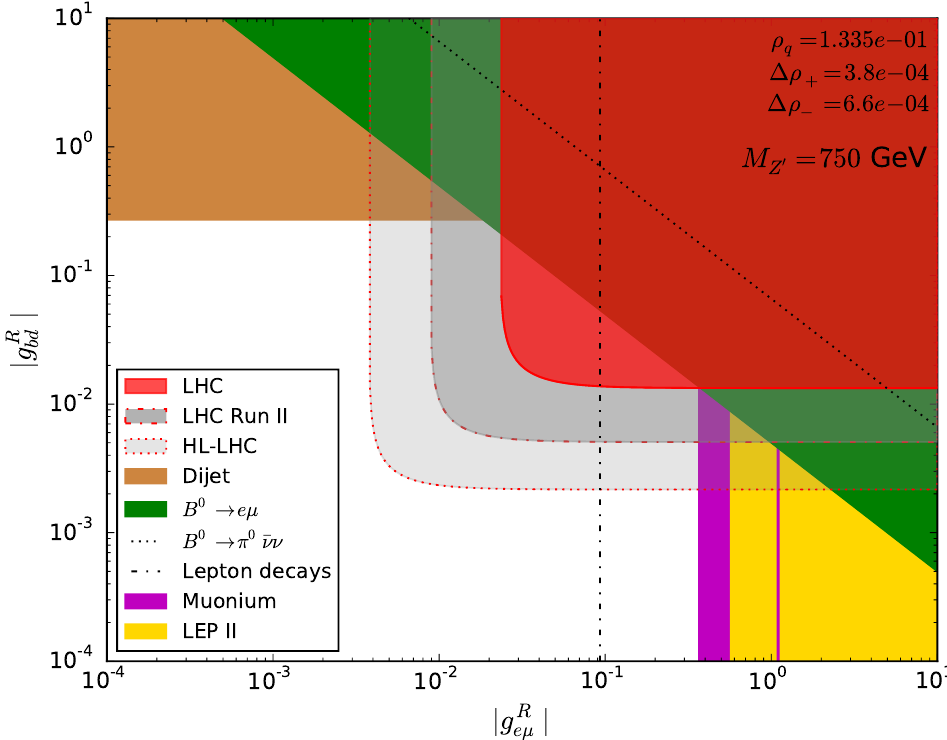
Figure 3 . The (cid:13)avor-violating couplings g R and g R for a Z 0 boson of M Z 0 = 750 GeV and a e(cid:22) bd coupling ratio of (cid:26) q = g L =g R = 0 : 1335 (for an explanation of (cid:1) (cid:26) see section 3.1.1). The red area bd bd p indicates the limit from the ATLAS analysis of the process pp ! e(cid:22) at s = 8 TeV. The red dash-dotted and dashed lines are projections to the LHC Run II and HL-LHC. The green area is the limit coming from the meson decay B 0 ! e(cid:22) . The gold and magenta areas are purely leptonic limits coming from LEP and muonium oscillation constraints. The black dotted line is the exclusion limit from B 0 ! (cid:25) 0 (cid:22) (cid:23)(cid:23) and the black dash-dotted line the limit from lepton decays. These last two limits, however, apply only for left-handed lepton couplings. The brown area depicts the limit from the four-quark contact interaction